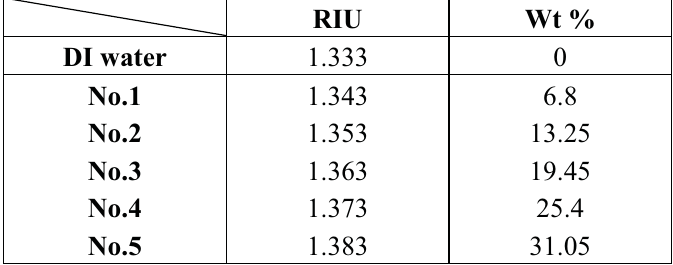
Table 1. Refractive index of various sucrose solution concentrations